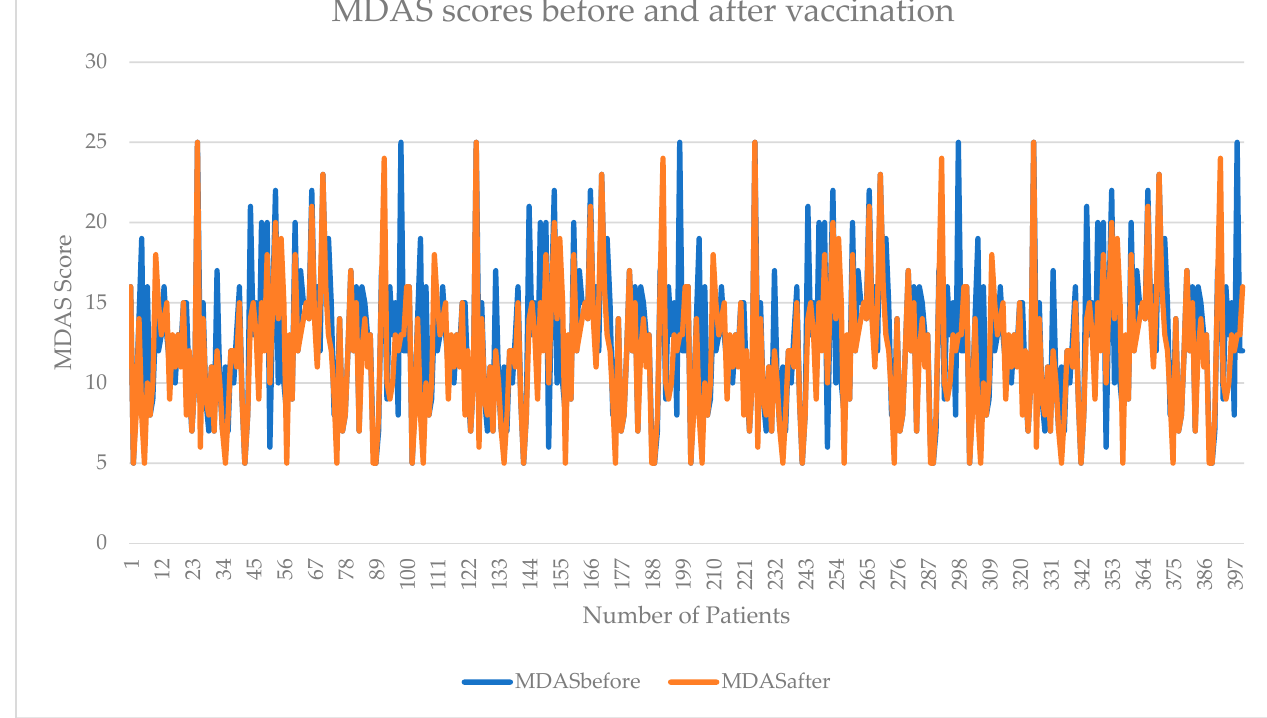
Figure 2. Comparison of anxiety scores of patients before and after vaccinations. MDAS: Modified dental anxiety scale.